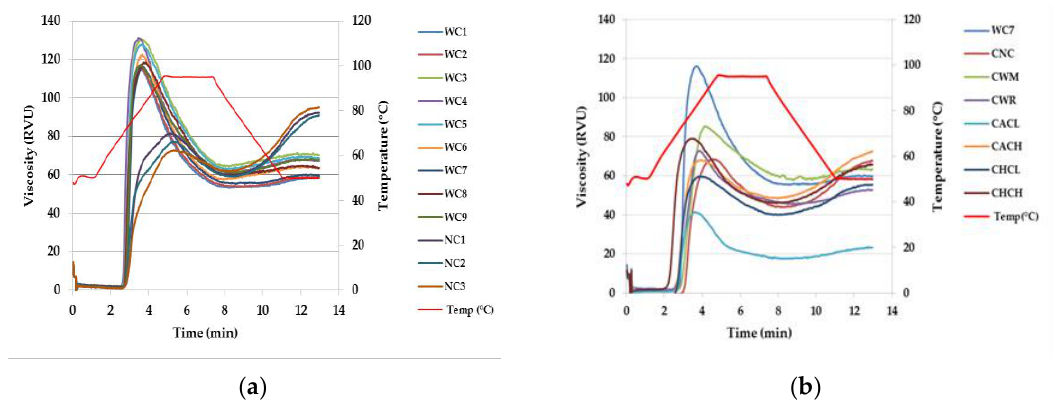
Figure 4. Pasting profiles of (a) nine Thai non-GM bred waxy cassava starches (WC1–WC9) and three wild-type normal cassava starches (NC1–NC3) and (b) Thai non-GM bred waxy cassava starch (WC7), commercial normal cassava starch (CNC), commercial waxy maize starch (CWM), commercial waxy rice starch (CWR) and commercial acetylated cassava starches with low and high degrees of substitutions (CACL and CACH) and commercial hydroxypropylated cassava starches with low and high degrees of molar substitutions (CHCL and CHCH).